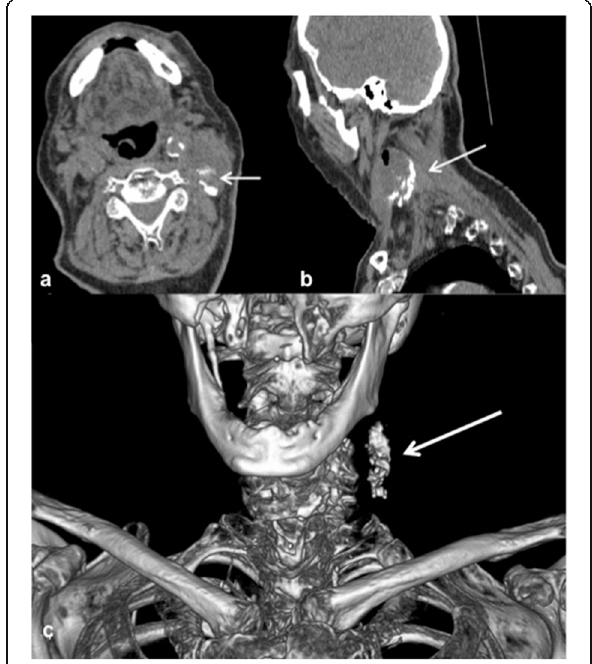
Fig. 3 Computed tomography (CT) images of patient number 1. Axial, sagittal, and three-dimensional CT reconstructions of patient number 1 with a large necrotic tumour on the left neck side. During injection, the holmium microspheres were clearly visible on ultrasound as a cloud in the necrotic fluid and did precipitate after some minutes at the bottom of the tumour. The dorsal and caudal accumulation of 166 Ho microspheres in the tumour is also well visible in the three images obtained in supine position (arrows in a , b , and c